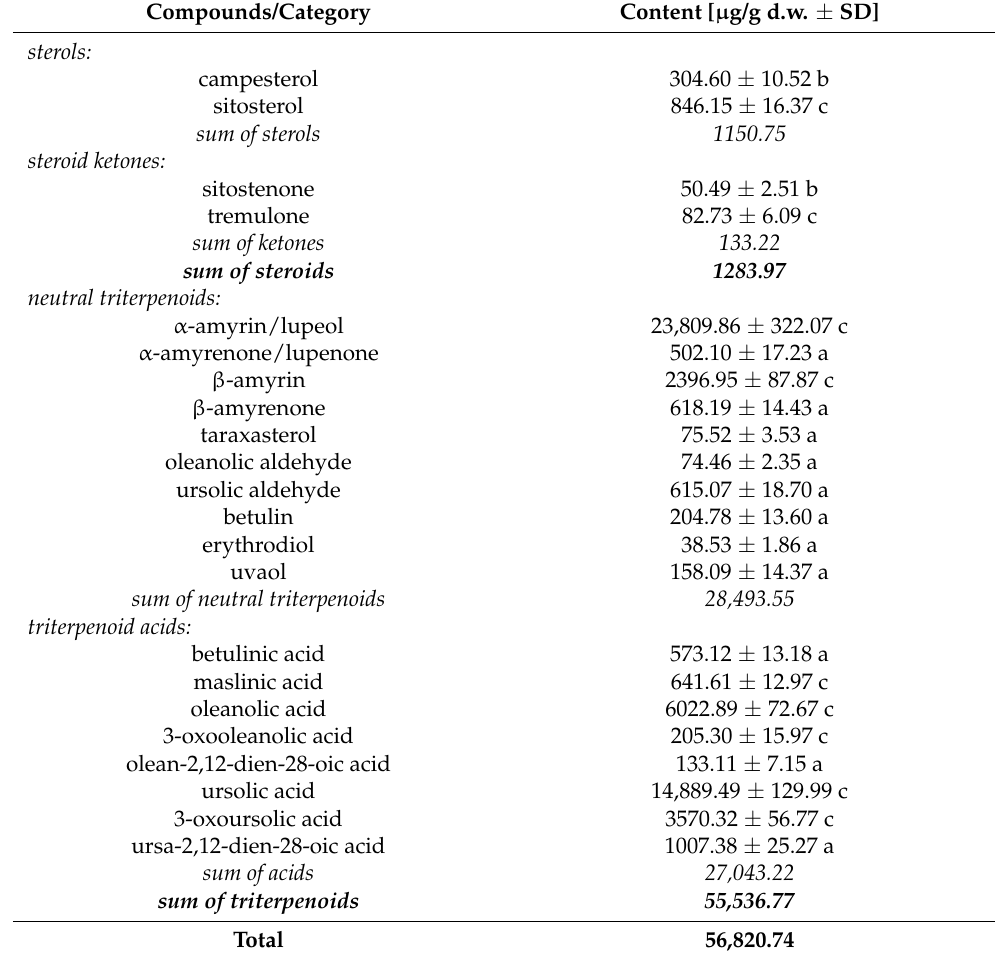
Table 2. Content of steroids and triterpenoids in the aerial part of Erica arborea .